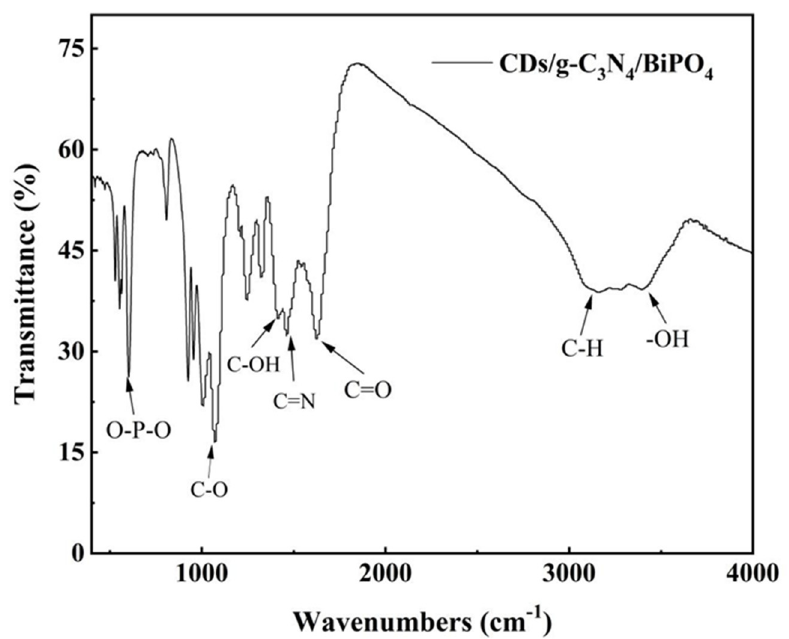
Figure 4. FT − IR spectra of the CDBPC composite.